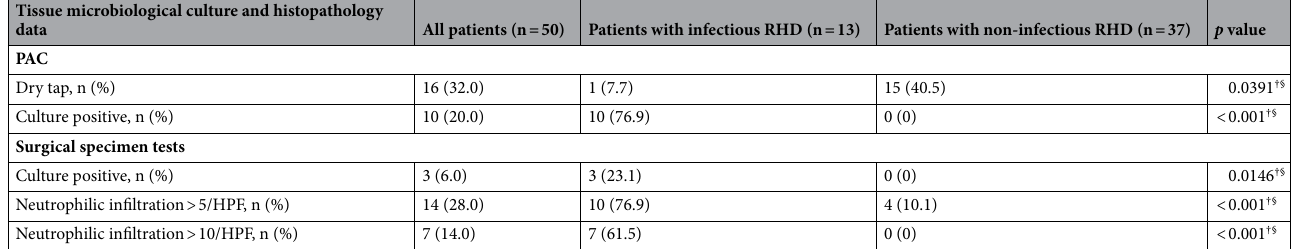
Table 5. Patients tissue microbiological culture and histopathology data. HPF High-powered field, IQR Interquartile range, PAC Preoperative joint aspiration culture, RHD Rapid hip destruction. † Fisher’s exact test. § Statistically significant.